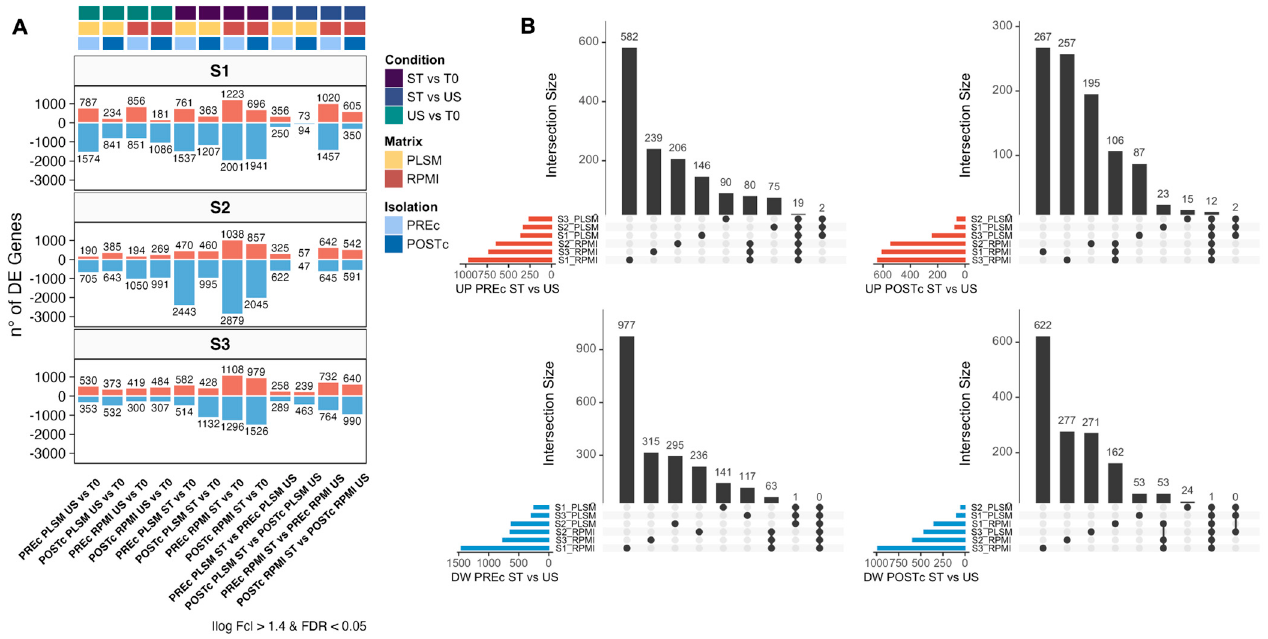
Figure 3. Differential gene expression analysis. Number of genes up-regulated (red) and down-regulated (blue) among US vs. T0, ST vs. T0, and ST vs. US comparisons, analyzed in the 3 study participants (S1, S2, and S3) in both PREc and POSTc. Genes with |log fold change| > 1.4 and adjusted p -value (FDR) < 0.05 were considered differentially expressed (DEGs) ( A ). Overlap of genes up-regulated (UP, red) or down-regulated (DW, blue) after stimulation among donors and matrices for CD4 + T cells isolated before (PREc) or after (POSTc) culture ( B ).